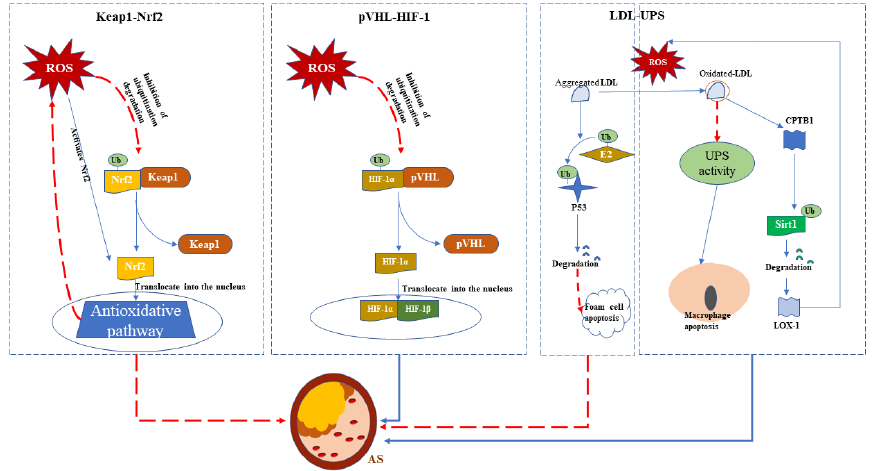
Figure 3. Three main pathways linking the ubiquitin – proteosome system (UPS) and oxidative stress in atherosclerosis (AS) progression. The red dotted line indicates inhibition or alleviation, and the solid blue line indicates promotion or activation. Ub, ubiquitin; ROS, reactive oxygen species; LDL, low-density lipoprotein.